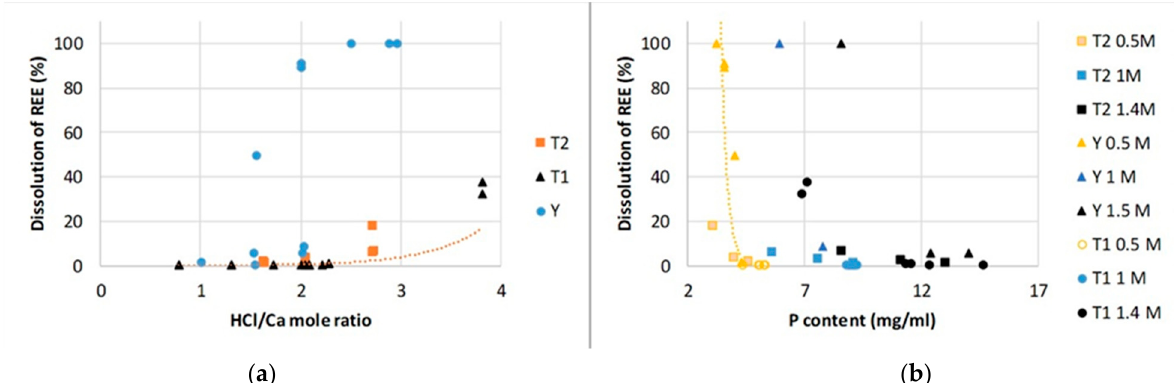
Figure 5. Dissolution of REEs depending on HCl dosage ( a ) and P content in the solution at different HCl concentrations ( b ) where T1 — Toolse 1, T2 — Toolse 2, and Y — Ülgase with the numbers indicating acid molarity.